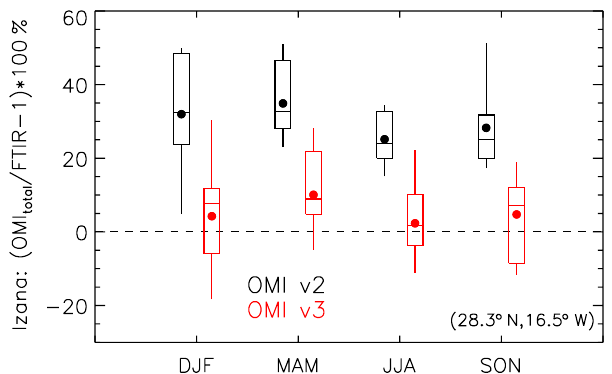
Figure 9. OMI V total versus ground-based FTIR at Izana in Tenerife (28.3 ◦ N, 16.5 ◦ W), seasonally for 2005–2011. SPv2 and SPv3 are shown for FOVs within 50km of the ground-based site. Photochemical corrections have been made for the OMI overpass time. Box-and-whisker plots show 10th, 25th, 50th, 75th, and 90th percentiles; the dots in the middle are the means.